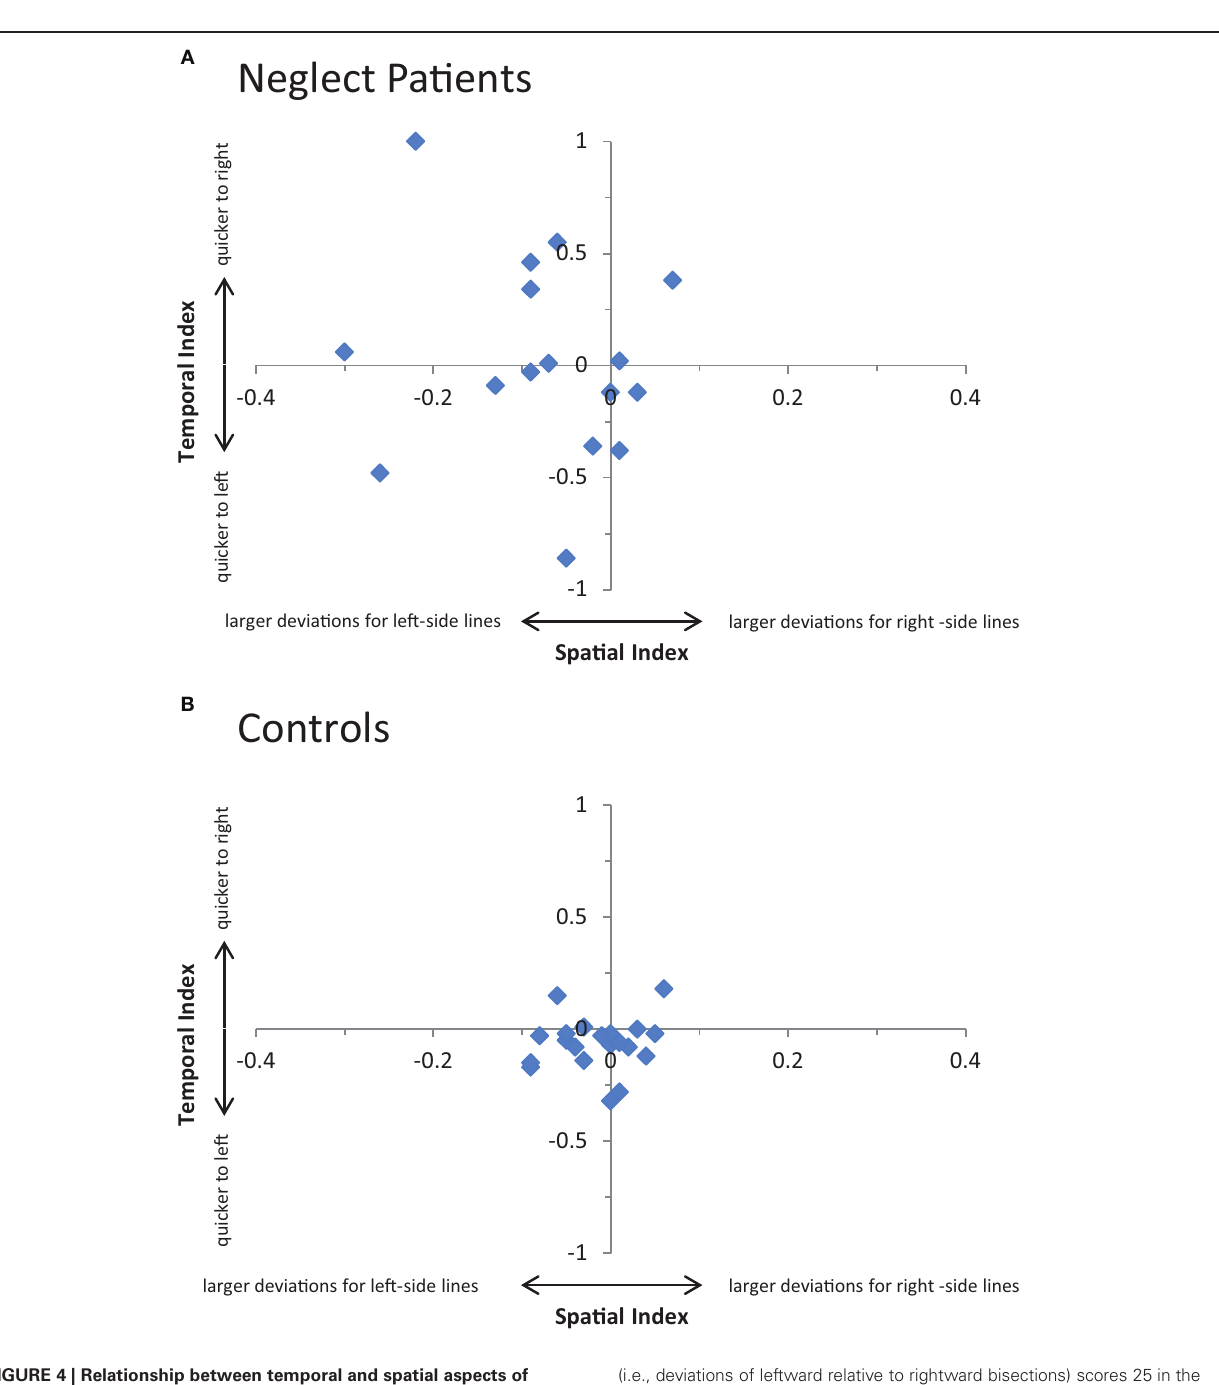
(i.e., deviations of leftward relative to rightward bisections) scores 25 in the line bisection task. See main text for details (B) Shows the corresponding 26 performance of the control